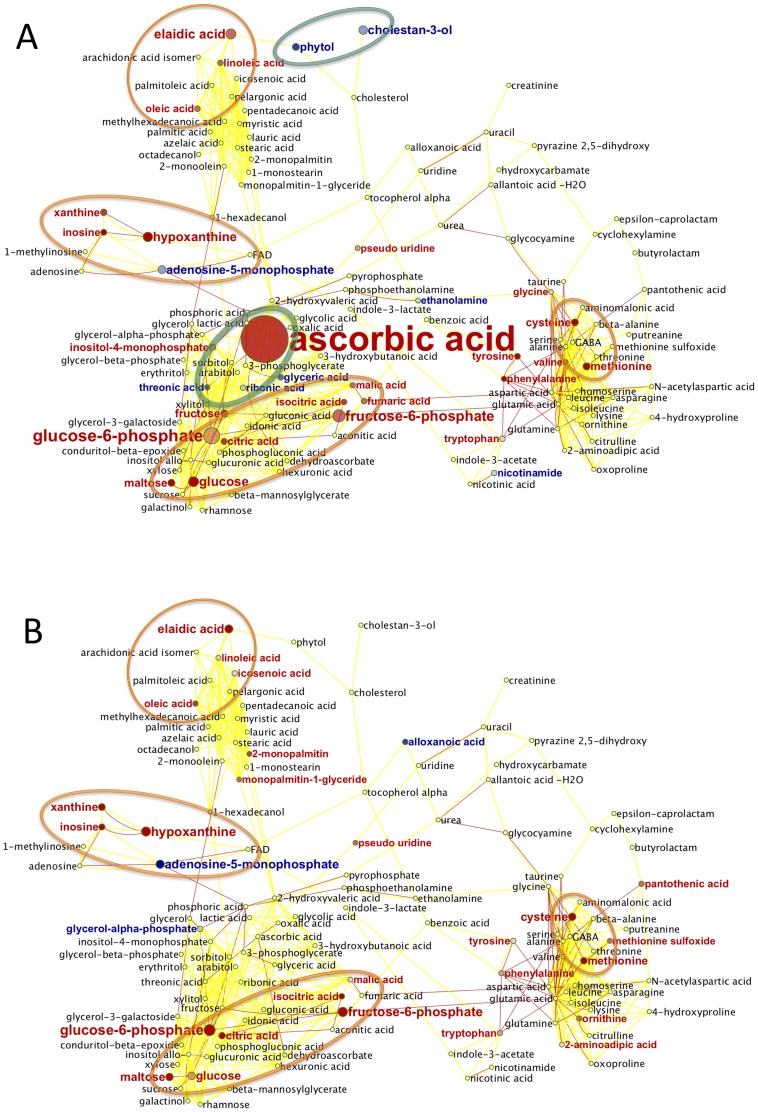
Effect of lithium treatment on cerebellum metabolome.Metabolic network of wild-type and Sca1154Q/+ cerebellum phenotypes. A. Wild-type mice. B. SCA1 knock-in mice. Red nodes: Increased metabolite levels under Lithium treatment; blue nodes: decreased levels. Node shades indicate ANOVA significance levels, node size reflect differences in magnitude of regulation. Red lines: reactant pair relationships obtained from the KEGG reaction pair database. Yellow solid lines: chemical similarity >0.5 Tanimoto score (Tanimoto scores range between 0 to 1, where 1 reflects identical structures). Yellow broken lines: chemically closest structure at <0.5 Tanimoto scores. Green circles group significant compounds that changed only in the Wild-type genotype. Orange circles group significant compounds that changed in both genotypes.